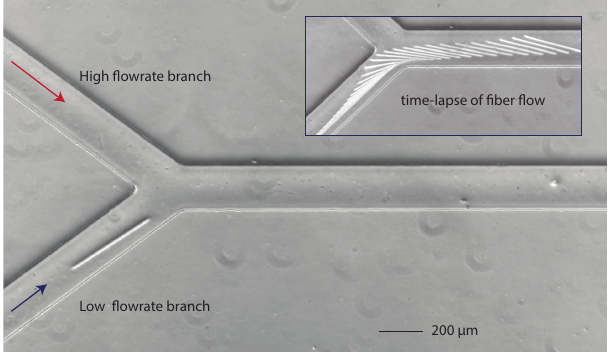
Figure 2. Y-shaped microfluidic channel for in-flow fabrication with a fiber made in the low-flow rate branch. Inset: successive positions of the flowing fiber.